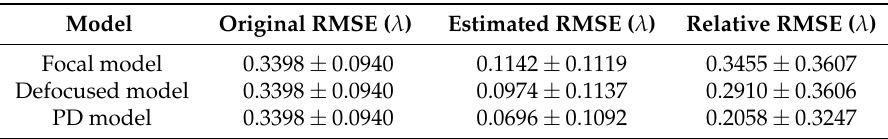
Table 7. Summary accuracies (RMSE and standard error: λ of Zernike coefficients estimated by PD-CNN after acceleration across 3000